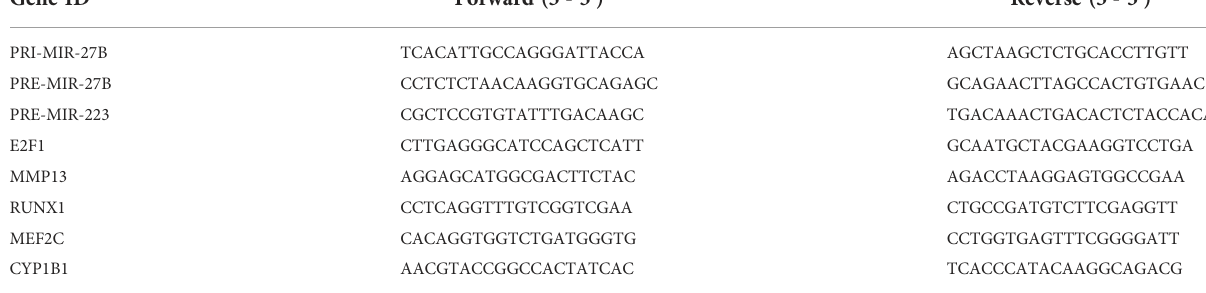
TABLE 1 SybrGreen primer sets used in QPCR